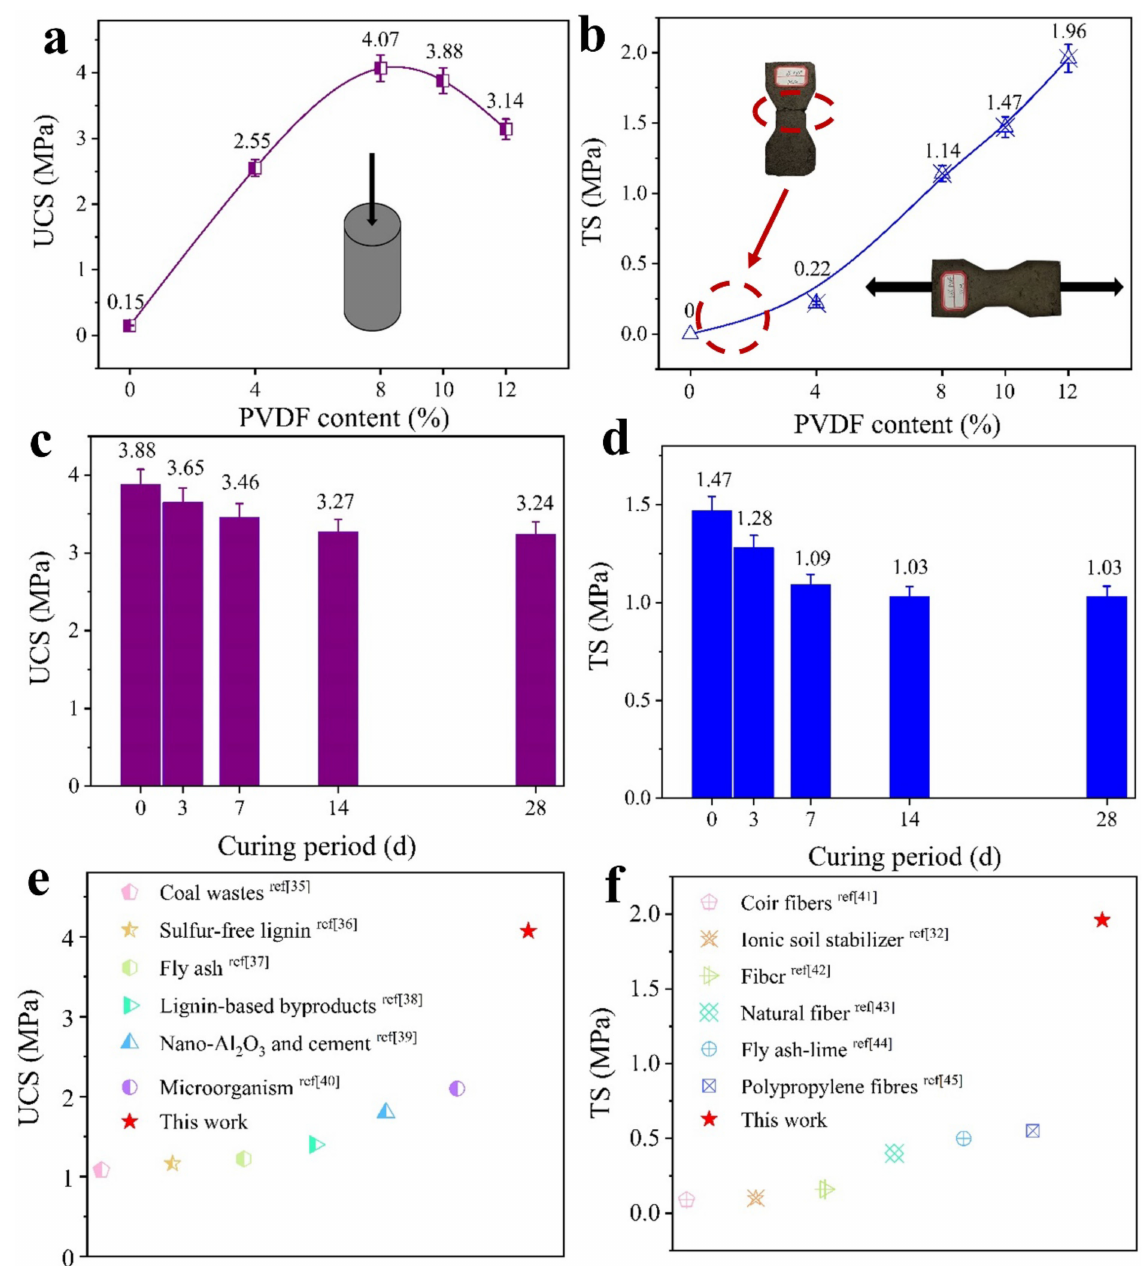
Figure 6. Mechanical properties of PVDF-MCM. Unconfined compressive strength (UCS) ( a ) and tensile strength (TS) ( b ) of PVDF-MCM with different contents; Influence of curing period on UCS ( c ) and TS ( d ) for M-10; Optimum UCS ( e ) and TS ( f ) for several reinforcement